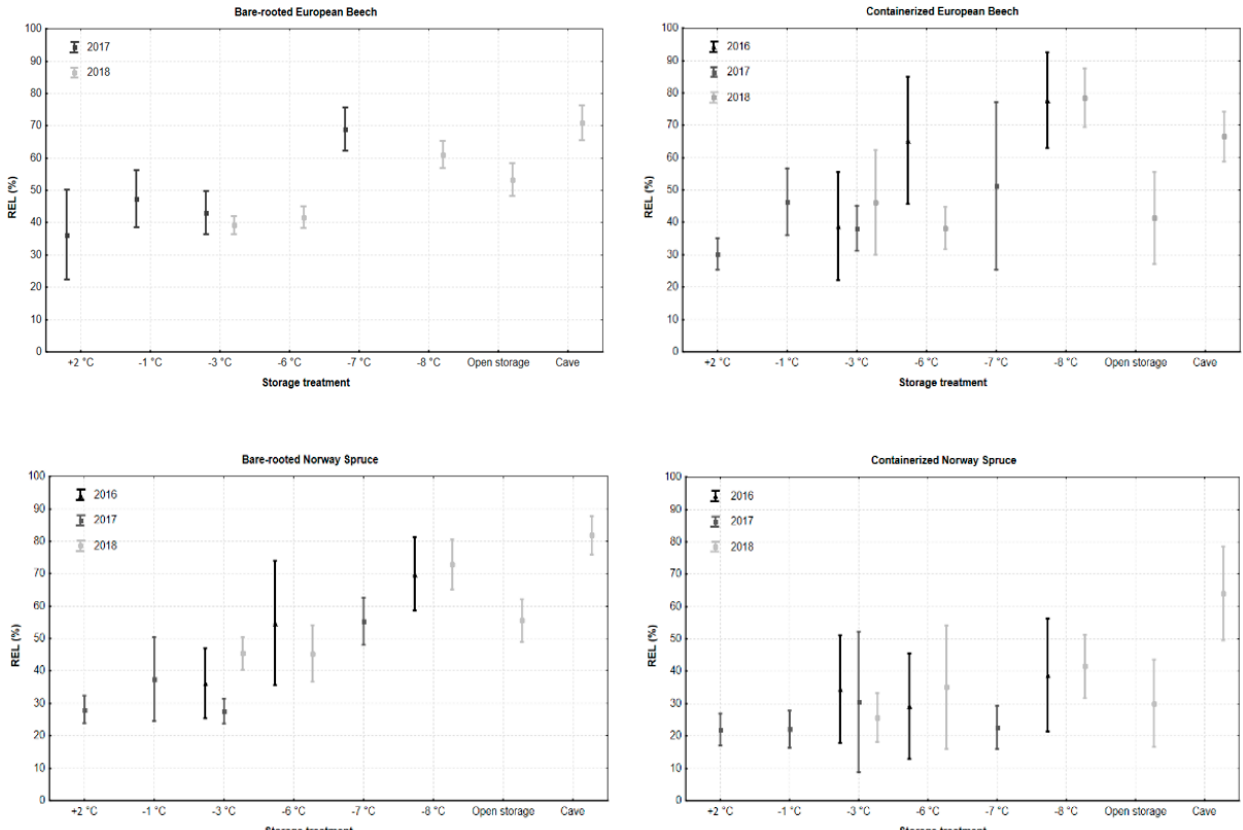
Figure 4. Root Electrolyte Leakage, approx. in the middle of the storage period of the bare-rooted and containerized European beech and Norway spruce plants in the various storage treatments in the three years of the research (low REL relates to higher plant viability).